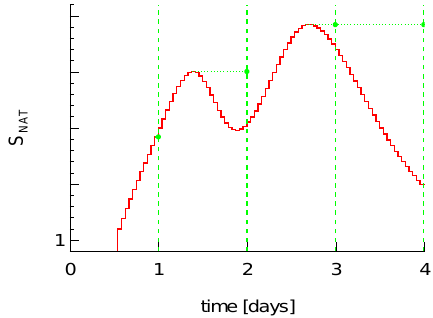
Fig. 2. Schematic of the determination of S max along an exemplary NAT air mass trajectory to demonstrate the principle of the parametri- sation (no absolute values given). The red line corresponds to the hourly calculated values of S NAT and the green dots indicate the derived value of S max for each day of simulation. NAT